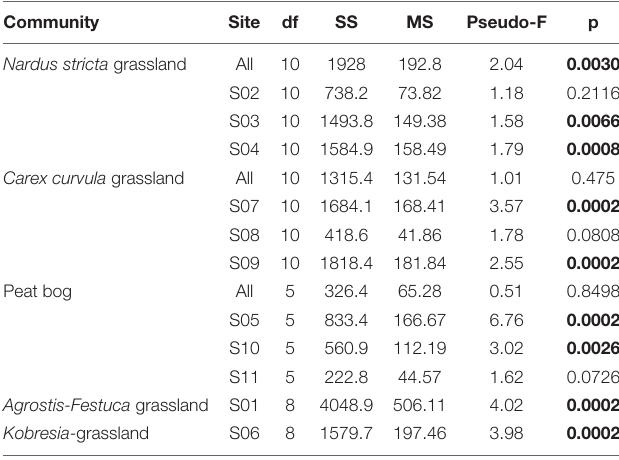
TABLE 4 | Exclosure effects (exclosure × year interaction) on species composition of the communities and single sites. Community Site